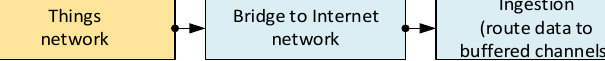
Figure 2. General network structure with network bridge.